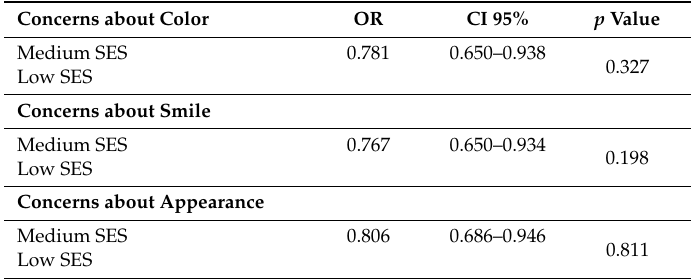
Table 3. Bivariate analysis between self-perception and different socioeconomic levels in the TF 6–7